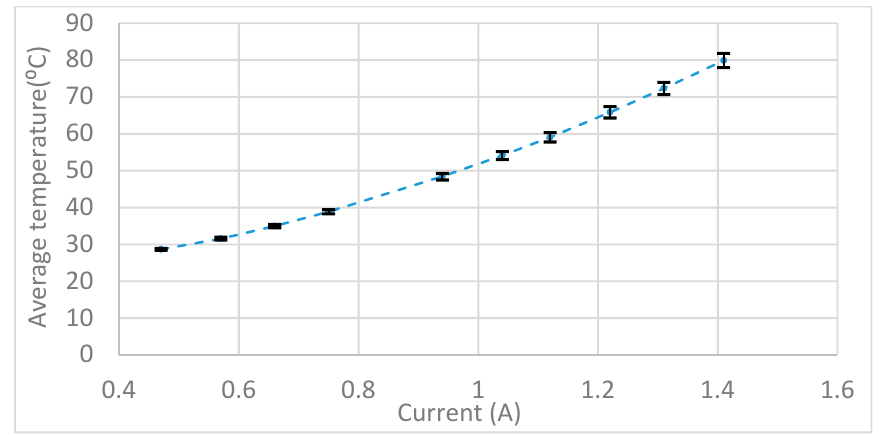
Figure 8. Temperature response of the aluminum bridge at different current levels using an actuation frequency of 3 kHz.